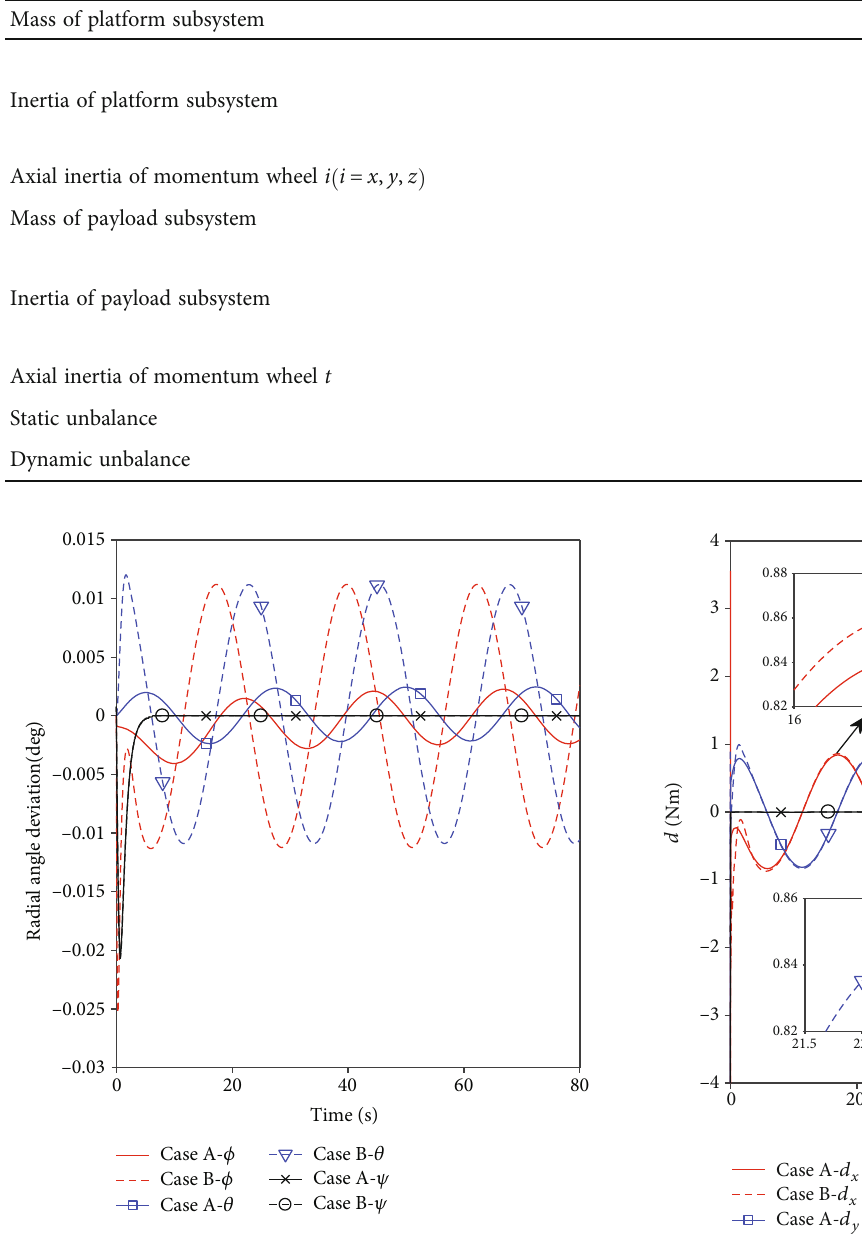
Figure 6: Radial angle deviation of AMB.